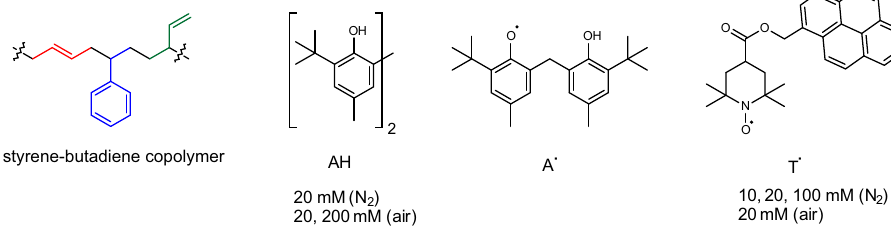
Fig. 1 The styrene-butadiene copolymer and radical scavengers. The sheared polymer had T g = − 35 °C and contained 30.5 ± 0.5% and 27.1 ± 0.7% by mass of styrene (blue) and 1,2-enchained butadiene (green), respectively, with the rest being 1,4-enchained butadiene (red), as determined by NIR spectroscopy (Supplementary Fig. 1). AH represents a class of antioxidant additives routinely used for protection of commercial polymers against thermooxidative aging 38,39 . A (cid:129) is a radical scavenger produced in situ when a macroradical abstracts phenolic hydrogen atom from AH. T (cid:129) combines a well-established radical trap 40 (TEMPO) with pyrene, whose characteristic absorption spectrum allows simple and accurate spectroscopic quantitation of the number of T moieties bound to a polymer chain. Bulk concentrations of AH and T (cid:129) used in a subset of our experiments are